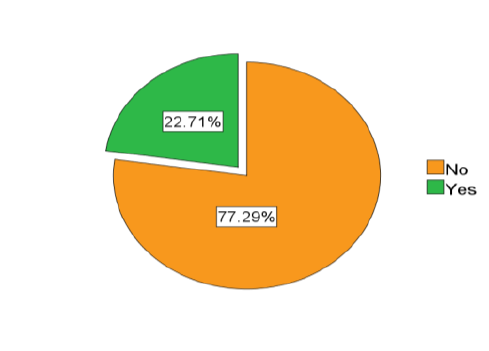
Figure 5: M&E tools used in Agroforestry Project